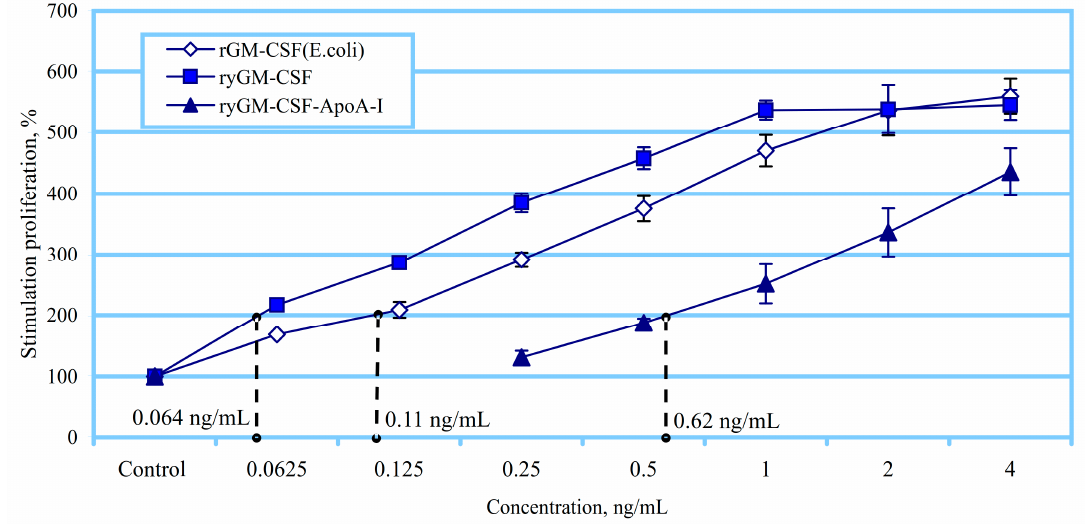
Figure 5. Influence of ryGM-CSF and ryGM-CSF-ApoA-I on the proliferation of TF-1 cells. Data are presented as mean ± standard error (SEM).